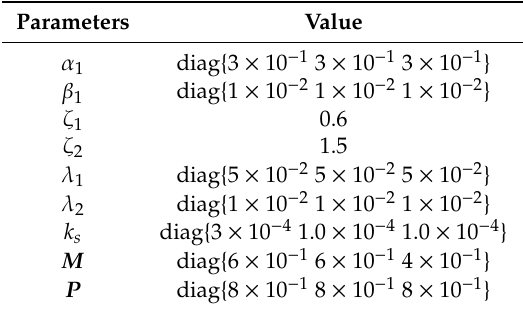
Table 3. Parameters of Gaussian mixture model-fixed-time control (GMM-FTC).